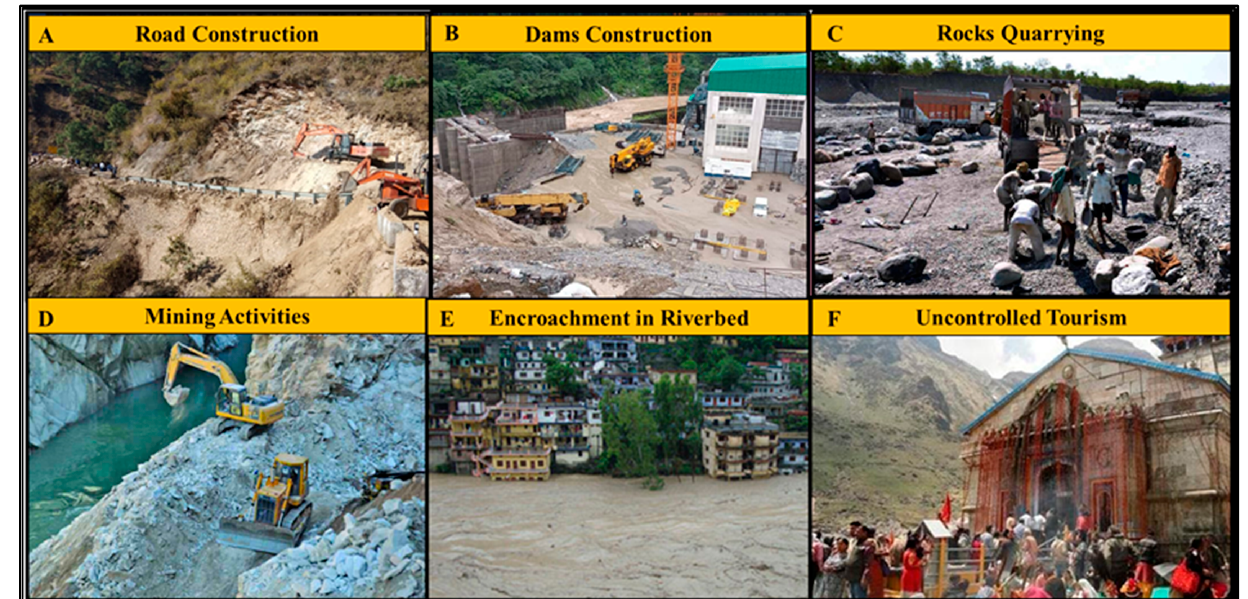
Figure 11. The impact of anthropogenic activities on the degradation of river ecosystem in Uttarakhand. ( A ) (Source: https://sandrp.in/2020/02/24/uttarakhand-road-widening-work-in-almora-damages- traditional-water-sources/ (accessed on 6 June 2022)), ( B ) (Source: https://sandrp.in/2021/09/17 /uttarakhand-cloud-bursts-around-vyasi-hep/ (accessed on 6 June 2022)), ( C ) (Source: https://news. euttaranchal.com/uttarakhand-bans-quarrying-ganga-tributaries-following-ngt-order (accessed on 6 June 2022)), ( D ) (Source: https://news.euttaranchal.com/no-mining-within-10-km-national-parks- uttarakhand-high-court (accessed on 6 June 2022)), ( E ) (Source: https://www.downtoearth.org.in/ news/urbanisation/undone-by-rampant-mining-illegal-buildings-41450 (accessed on 6 June 2022)), ( F ) (Source: https://www.hindustantimes.com/cities/dehradun-news/uttarakhand-char-dham-yatra- to-kedarnath-halted-amid-heavy-rain-imd-warns-of-thunderstorms-101653301156476.html (accessed on 6 June